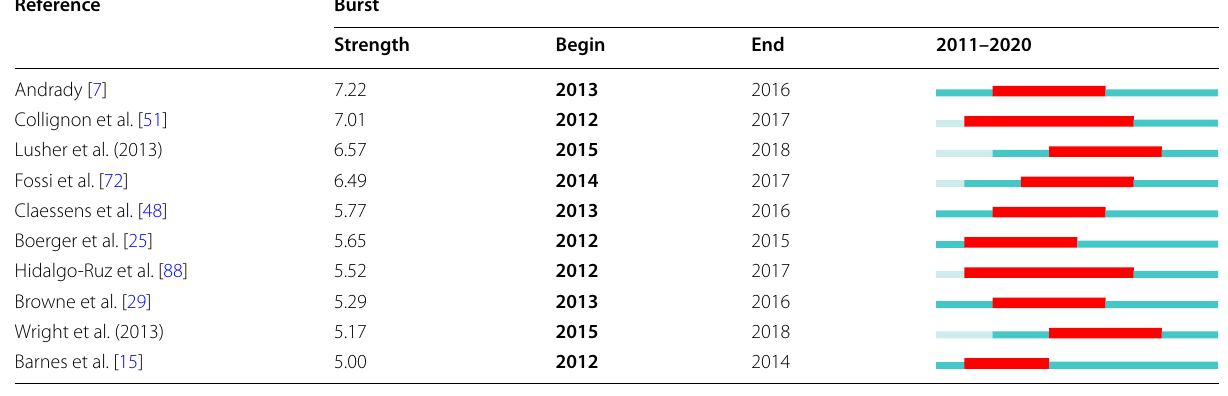
Table 4 Top 10 cited documents ordered by burst strength (2011–2020)